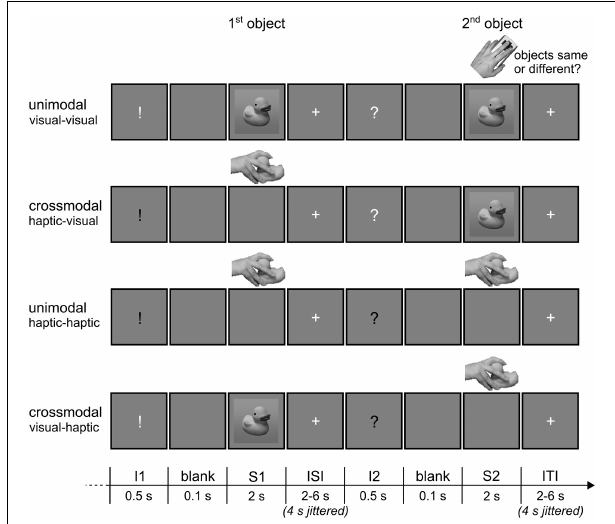
FIGURE 2 | Illustration of the event-related fMRI paradigm. Each trial consisted of a sample (S1) and a target object stimulus (S2), and subjects had to decide by button press whether the two objects were congruent (50%) or incongruent (50%). S1 and S2 were either haptic or visual stimuli, and both could be presented either within the same modality (unimodal) or across modalities (crossmodal). A white or black visually presented exclamation (I1) and question mark (I2) before the stimuli informed the subjects about the sensory modality S1 and S2, respectively, would be presented in. ISI, inter-stimulus-interval; ITI, inter-trial-interval. Reprinted from NeuroImage, 65, Kassuba et al., Vision holds a greater share in visuo-haptic object recognition than touch, p. 61, Copyright Elsevier Inc. (2013a), with permission from